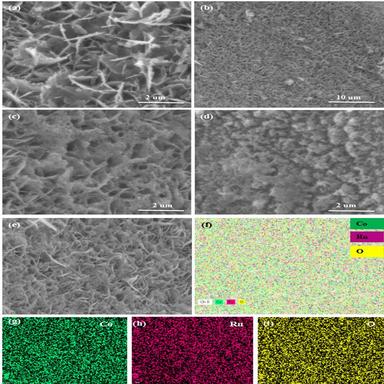
SEM image of (a) Co(OH)2/RuO2-1, (b, c) Co(OH)2/RuO2-2 and (d) Co(OH)2/RuO2-3 nanocomposites, (e–i) the element mapping images of different elements of Co, Ru and O in Co(OH)2/RuO2-2 prepared by 10 min of RuO2 deposition.